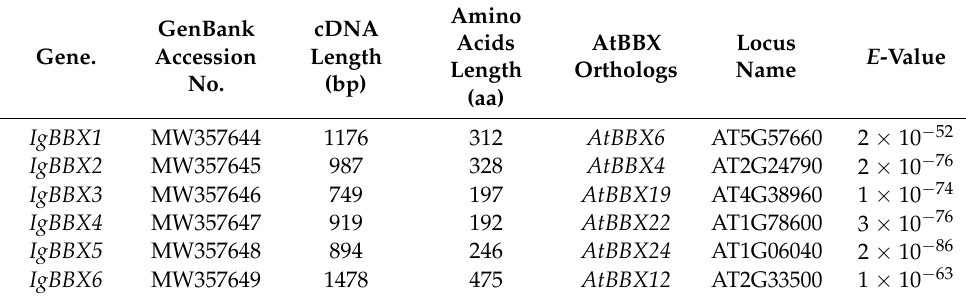
Table 1. IgBBX gene sequences and the identity of likely A. thaliana homologs.